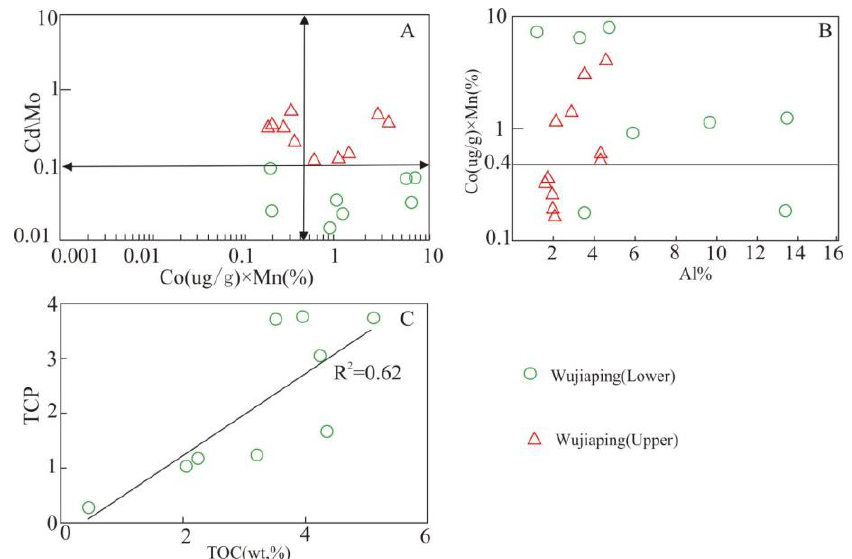
Figure 8. ( A ) Scatterplot of the Co × Mn and Cd/Mo of the shale of the Wujiaping Formation; ( B ) scatterplot of Co × Mn and A1%; ( C ) scatterplot of the TCP and TOC of the lower part of the Wujiaping Formation.